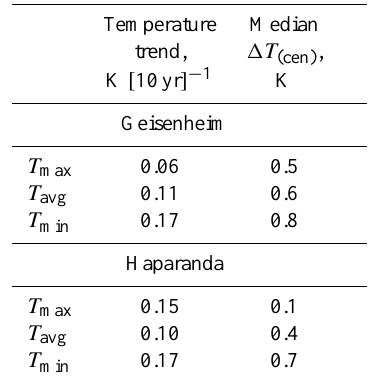
Table 3. Linear temperature trend in the complete raw data set from DWD Geisenheim (1882–2014) and SMHI Haparanda (1859– 2014), and median of the daily temperature difference between the village centre and the site of the current met station for the measure- ment